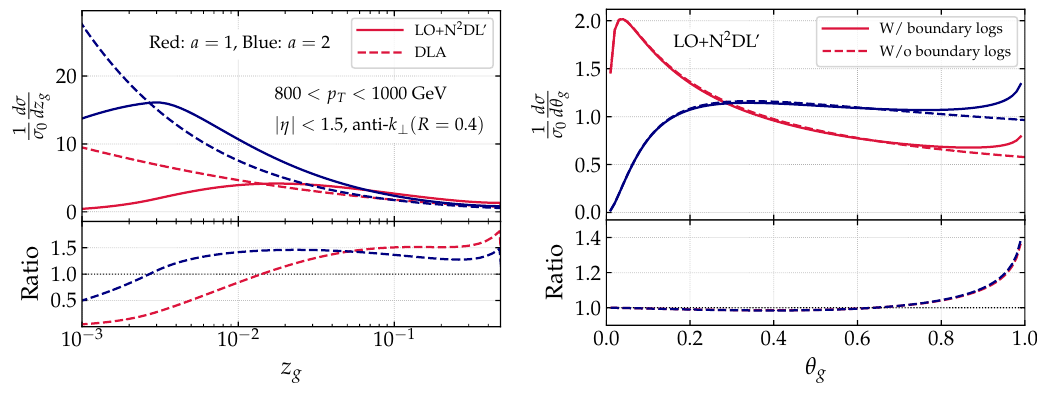
Figure 4 . Left: z g -distribution for a = 1 (red) and a = 2 (blue) at two different accuracies, DLA and LO+N 2 DL’ and their ratio. Right: θ g -distribution for a = 1 (red) and a = 2 (blue) with and without boundary logarithms in the LO+N 2 DL’ result and their